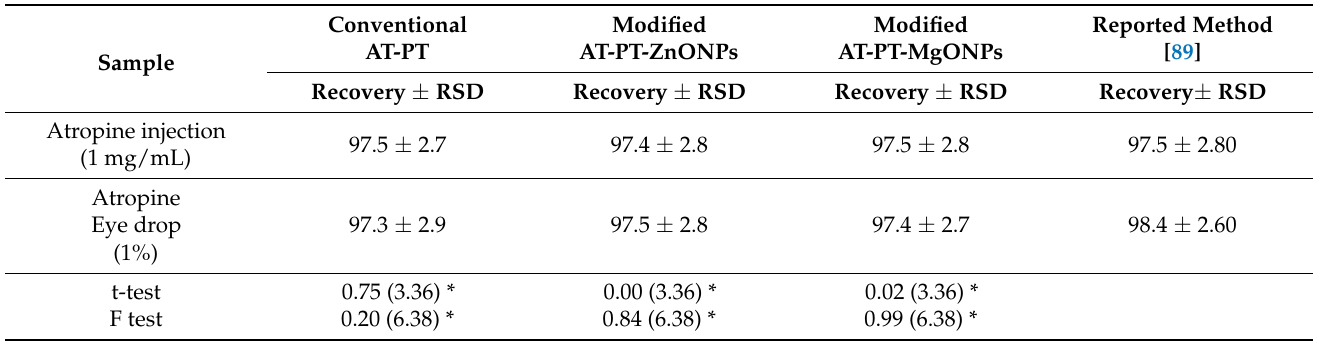
Table 5. The calculated results of atropine using the conventional coated wire AT-PT and modified AT-PT-ZnONP and AT-PT-MgONP sensors.